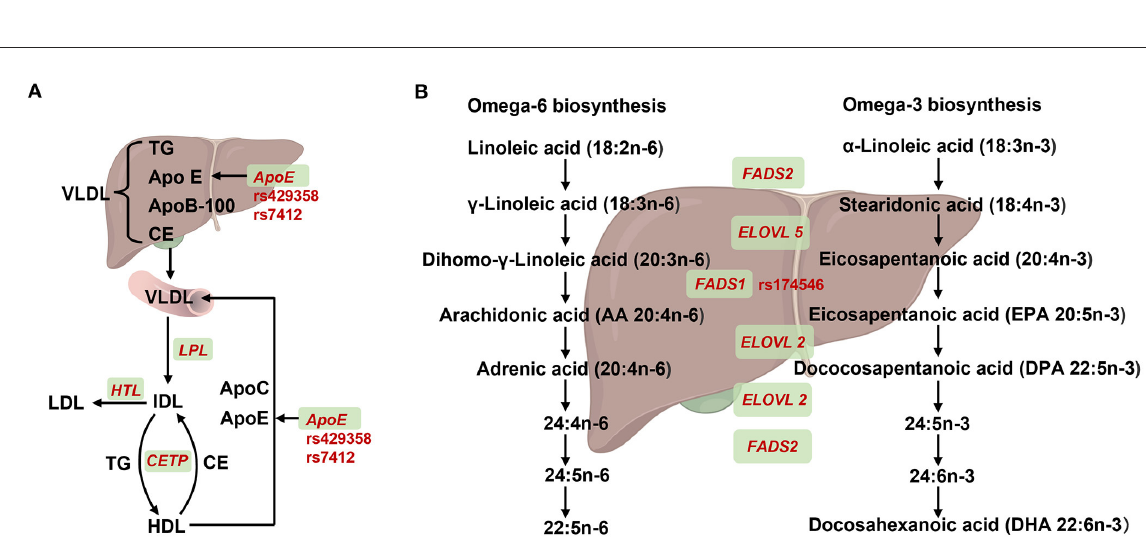
FIGURE2 Summary of SNPs for APOE and FADS1 in lipids synthesis or metabolism. (A) Effect of ApoE recycling and aggregation on lipoprotein. Very low-density lipoprotein (VLDL) containing triglycerides (TG), apolipoprotein E (encoded by ApoE ), apolipoprotein B-100 (encoded by ApoB-100 ) and cholesteryl ester (CE) that was synthesized in the liver and then secreted into the blood. The VLDL partially degreased by lipoprotein lipase (encoded by LPL ) and converted to intermediate-density lipoprotein (IDL). On one hand, IDL was hydrolyzed into low-density lipoprotein (LDL) by triglyceride lipase (encoded by HTL ). On the other hand, IDL and high-density lipoprotein (HDL) could mutual conversion by exchanging TG and CE with cholesteryl ester transfer protein (encoded by CETP ). In addition, nascent VLDL could be formed by acquisition of ApoE and ApoC from HDL. (B) Overview of FADS1 and FADS2 genes in desaturation steps necessary for polyunstatured fatty acid (PUFA) biosynthesis. For omega-6 biosynthesis, linoleic acid (LA) was absorbed from diet and converted to γ -Linoleic acid, Dihomo- γ -Linoleic acid by fatty acid synthase 2 (encoded by FAS2 ) and the elongase of very long chain fatty acid 5 (encoded by ELOVL5 ). Subsequently, the dihomo- γ -Linoleic acid was converted into long chain highly unsaturated PUFAs, including arachidonic acid (AA), adrenic acid, 24: (4n-6), 24: 5n-6, 22:5n-6 and 22:5n-6 PUFAS by fatty acid synthase 1 (encoded by FADS1 ), ELOVL2 and FADS2 . For Omega-3 biosynthesis, α -Linoleic acid was absorbed from diet and converted to stearidonic acid and eicosapentanoic acid by FADS2 and ELOVL5 , respectively. Subsequently, the eicosapentanoic acid